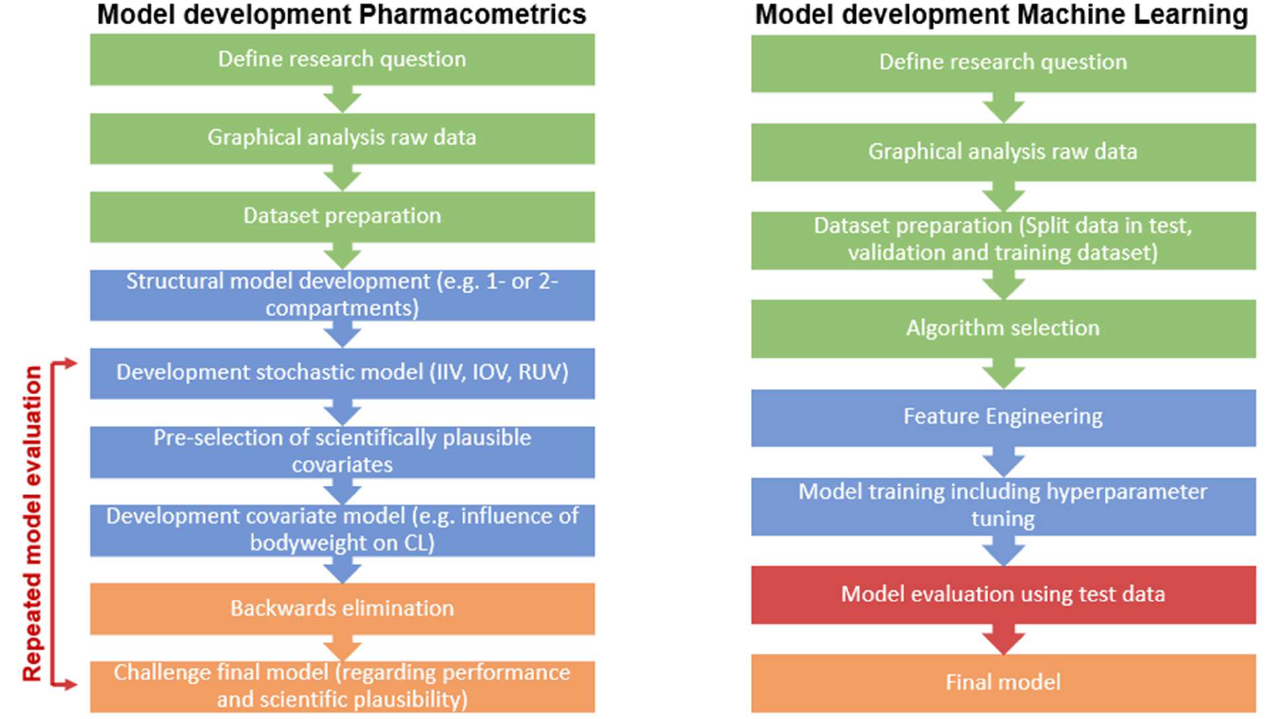
Figure 3. Comparison of the general model development workflow between pharmacometrics and machine learning. The different colors represent different steps of model development. Green: data preparation, blue: model building, red: model evaluation, orange: finalizing the model.